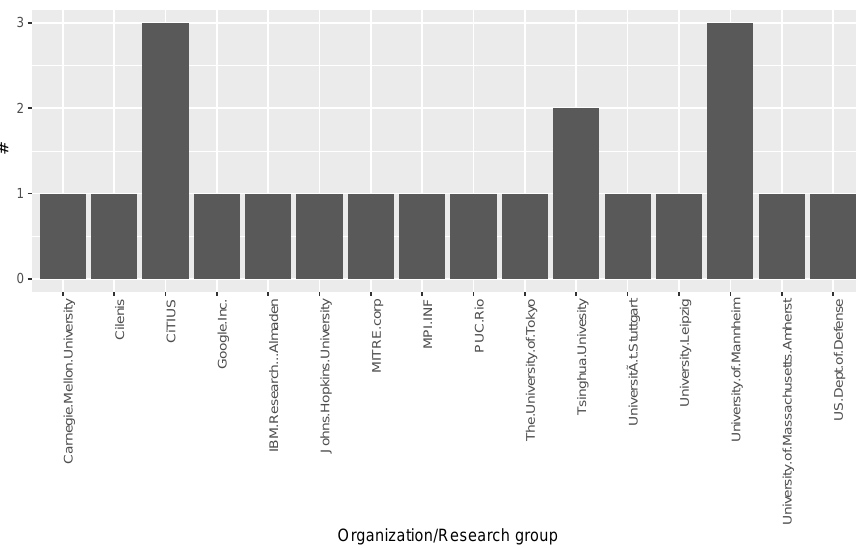
Figure 6. Distribution of the affiliation authors in primary studies. (Authors’ own).